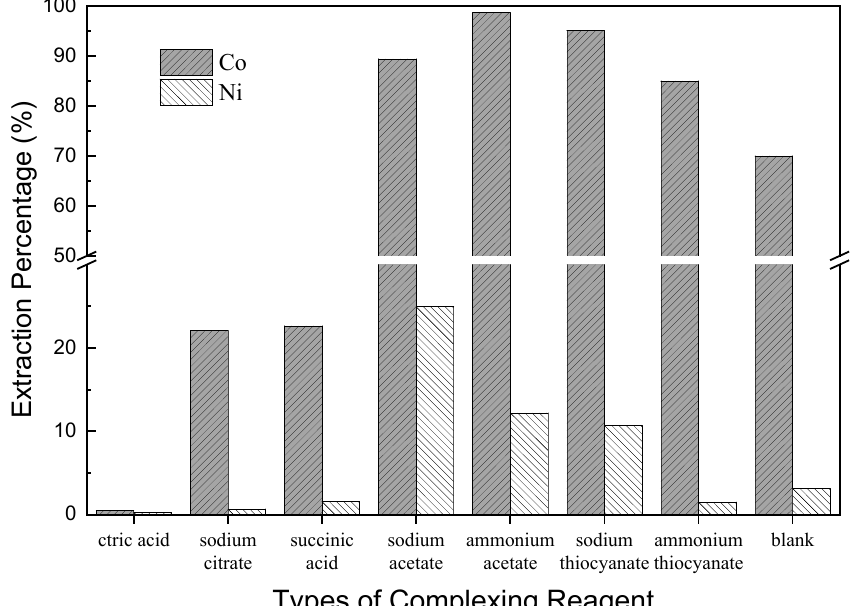
Figure 11. Extraction tendency of cobalt and nickel corresponding to types of complexing reagent. P-507/heptane—1:4 v/v ; saponification: 60%; O/A—1:1.